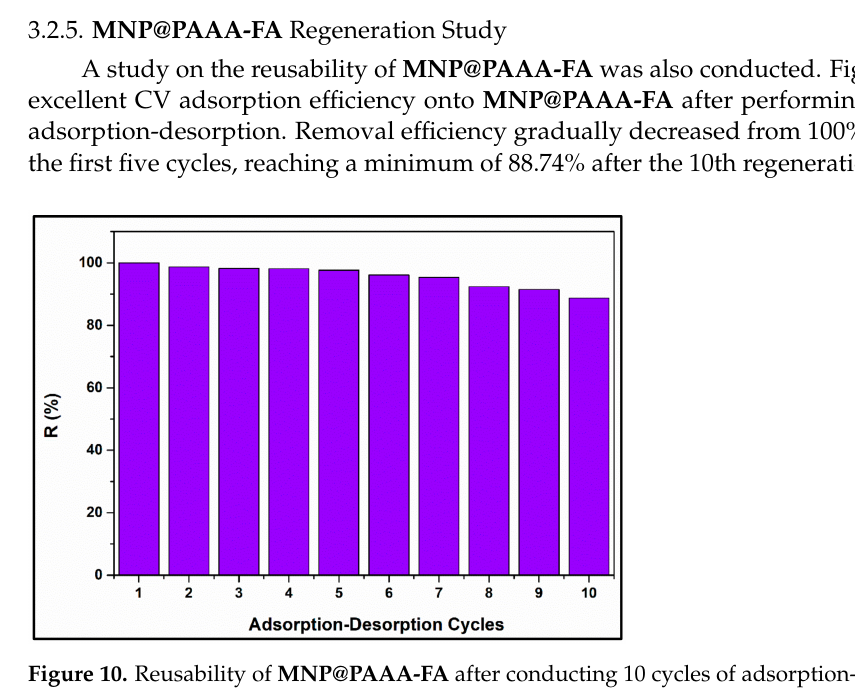
Figure 10. Reusability of MNP@PAAA-FA after conducting 10 cycles of